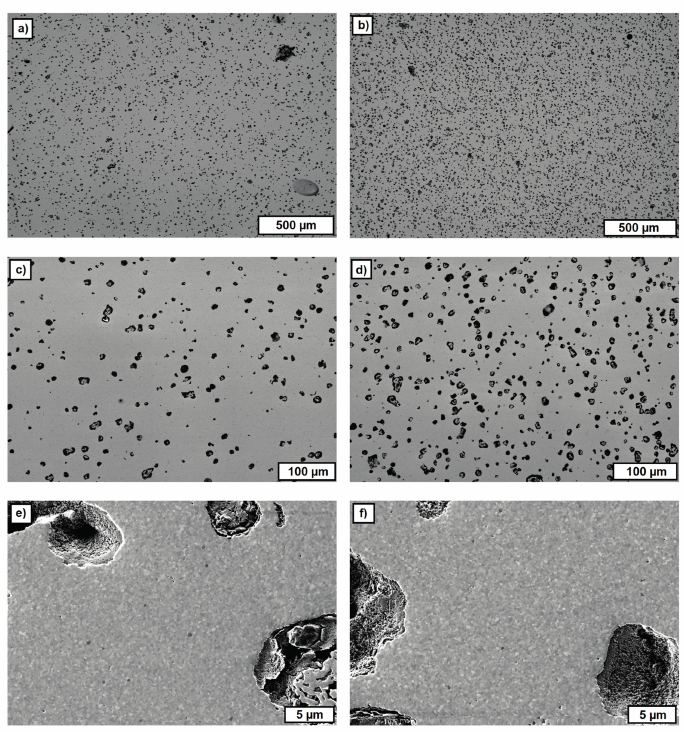
Figure 17. FESEM images of cross-sections of sintered single-material zirconia test samples with 5 vol.-% PS ( left ; ( a , c , e )) and 10 vol.-% PS ( right ; ( b , d , f )) as PFA in the suspension, with increasing magnifications from top to